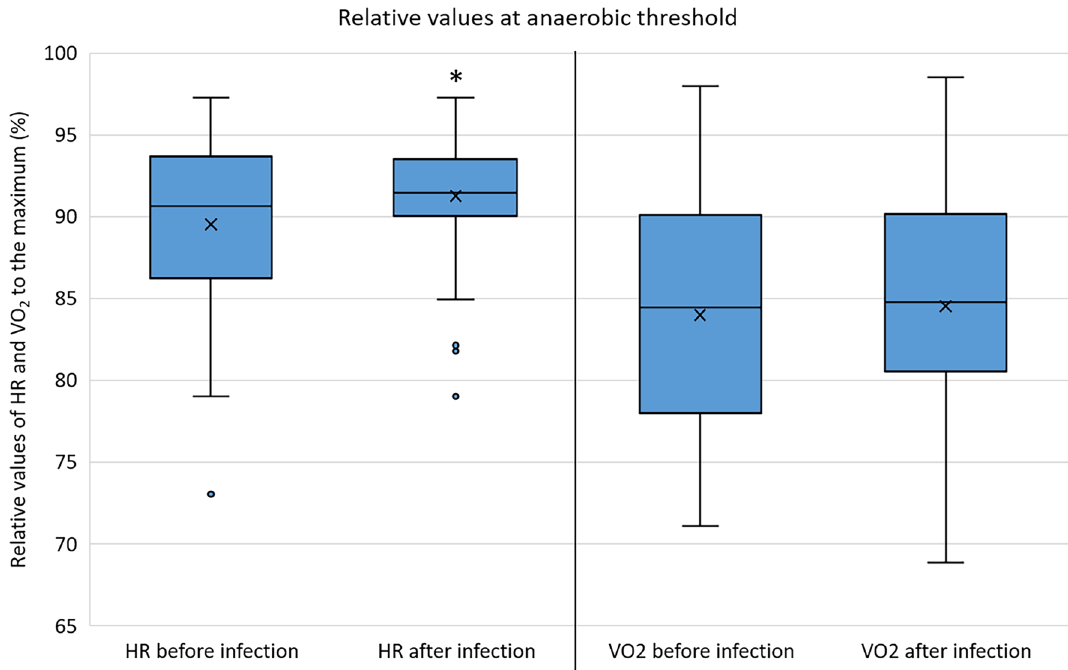
Figure 3. Relative heart rate and oxygen uptake at the anaerobic threshold in relation to the maximal values of the examined asymptomatic elite athletes before and after the SARS-CoV-2 infection. Abbreviations: HR, heart rate; VO2, oxygen uptake; *, p <